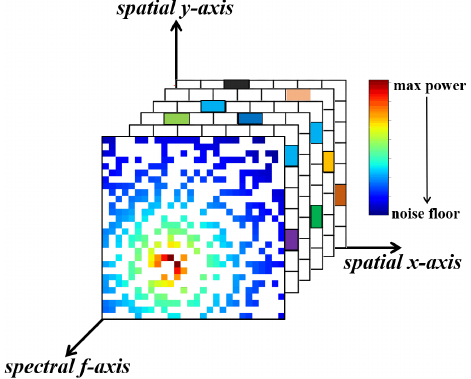
Figure 3. The incomplete, colored radio environment